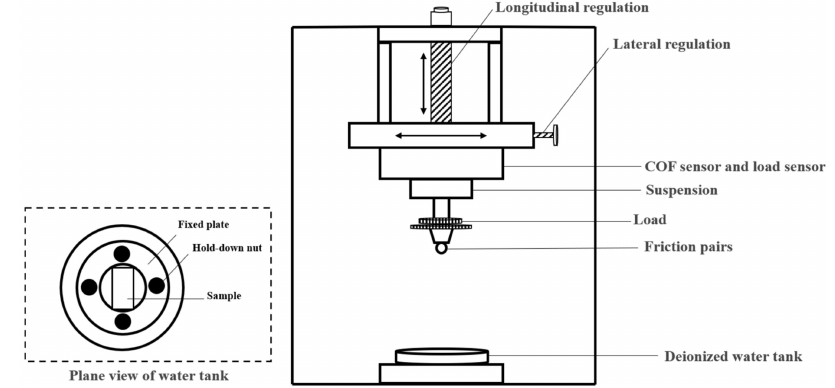
Figure 2. Schematic diagram of the CET-I-type reciprocating sliding tester